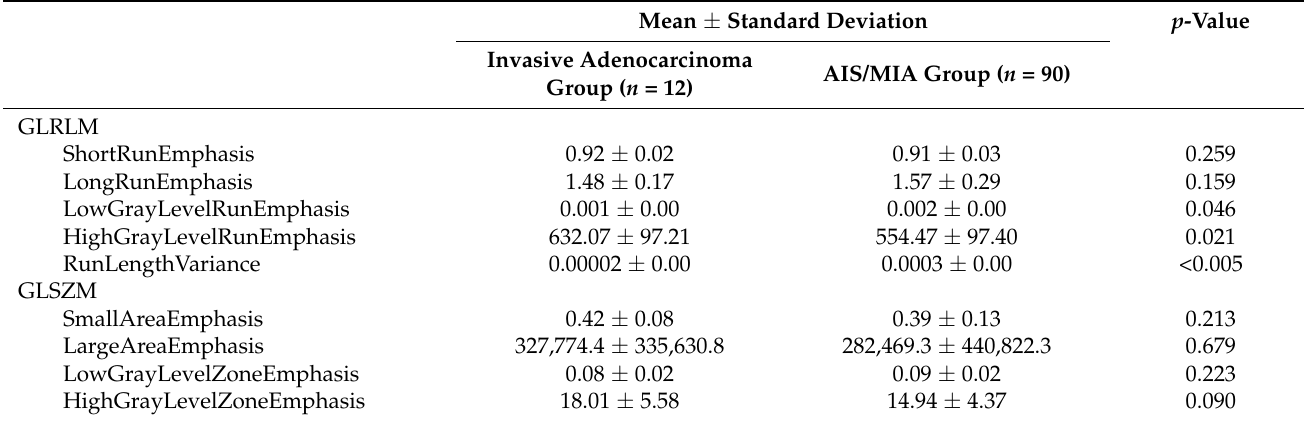
0.001 Values are presented as n (%) or mean ± standard deviation. AIS, adenocarcinoma in situ; CEA, carcinoembryonic antigen; CT, computed tomography; ECOG, Eastern Cooperative Oncology Group; FVC, forced vital capacity; FEV1, forced expiratory volume in 1 s; HU, Hounsfield unit; MIA, minimally invasive adenocarcinoma; C/T ratio, consolidation to tumor ratio.